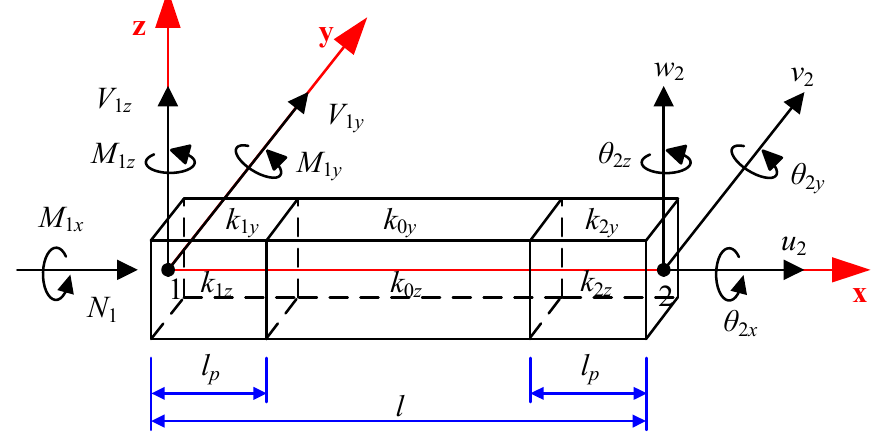
Figure 2. Three-segment variable stiffness model of the RC beam and column member.